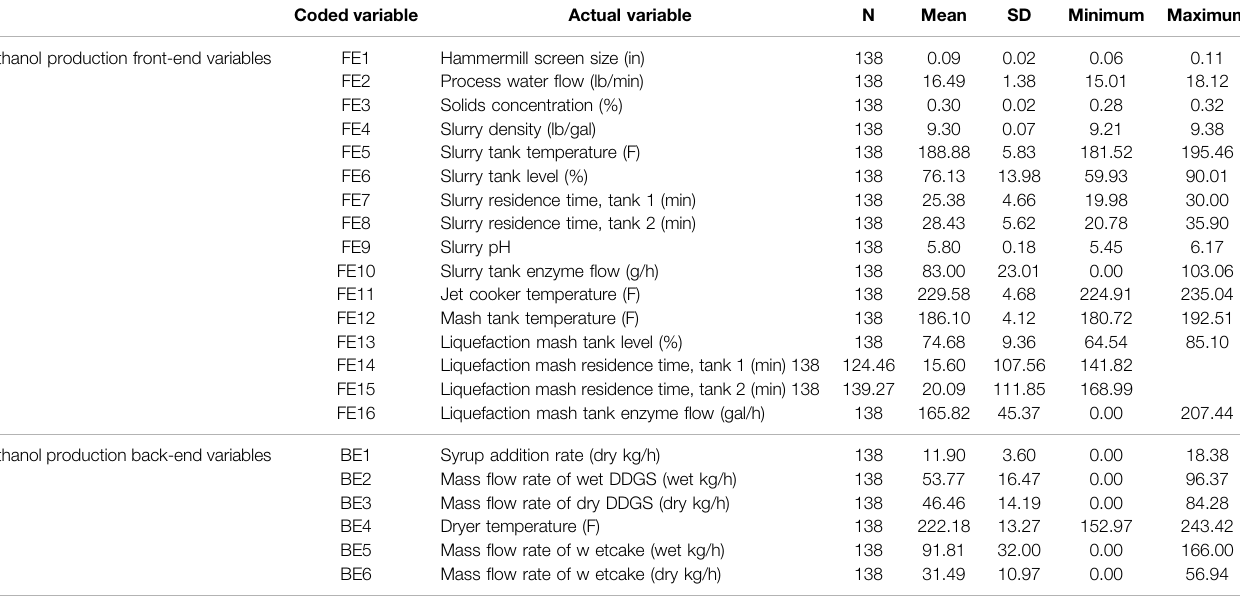
TABLE 1 | Summary statistics for each independent variable used in the study. a